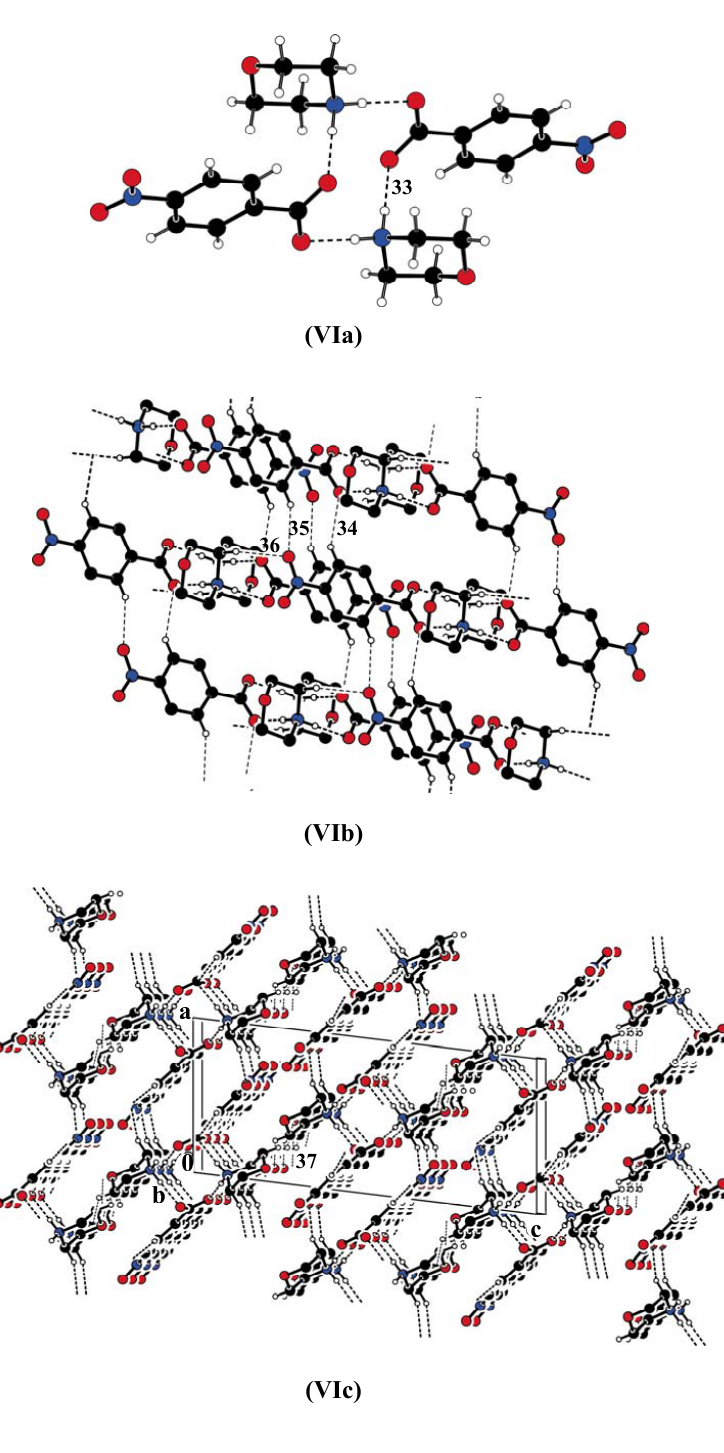
Fig. 7 ( VIa ) The fragment of the chain in VI , which represents the N-H ... O-C antidromic supramolecular synthon formed due to N2 ... O2 (33) hydrogen bonds (dashed lines). ( VIb ) Part of the chain in VI where antidromic synthons R 4 C3 ... O2 (34), C6 ... O3 (35) and C8 ... O3 (36) hydrogen bonds. ( VIc ) The crystal packing of VI showing the weak interactions between chains via C10 ... O5 (37) hydrogen bonds. Non-functional hydrogen atoms are omitted for